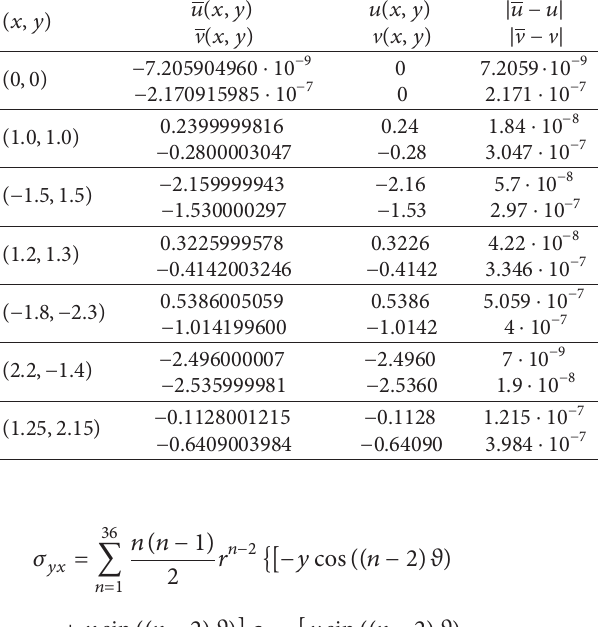
Table 1: Numerical results for Example